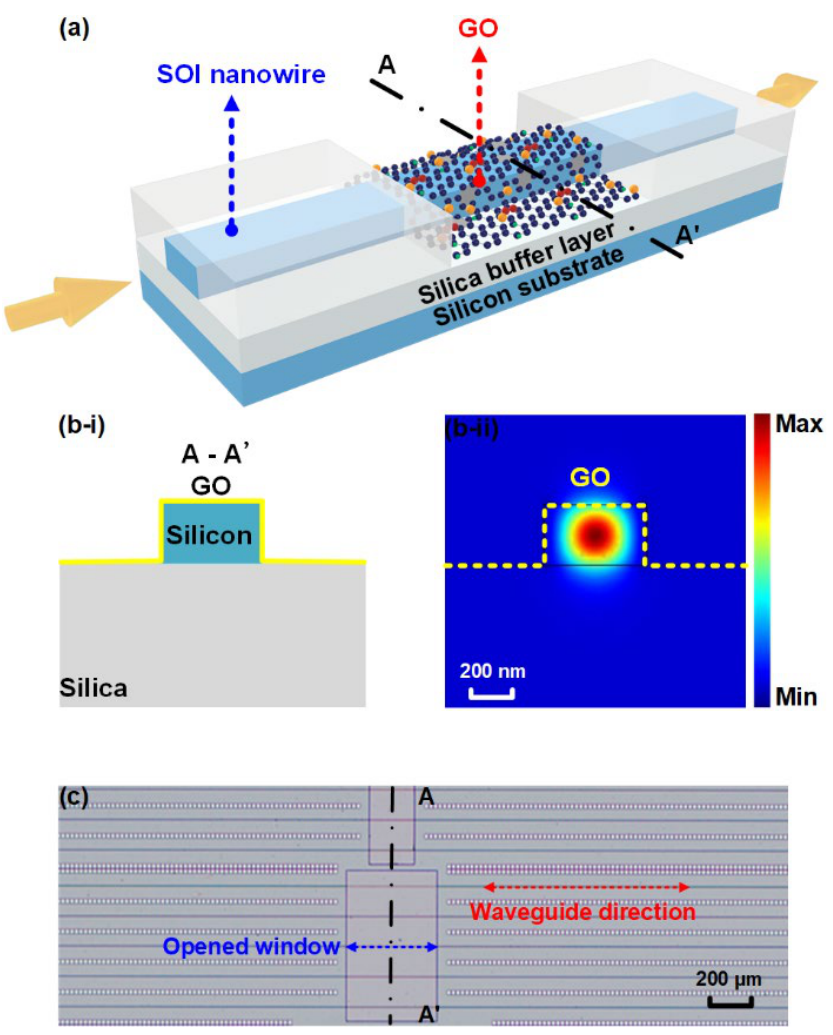
Figure 1. ( a ) Schematic illustration of a GO-coated SOI nanowire with a monolayer GO film. ( bi ) Schematic illustration of the cross section and ( bii ) the corresponding TE mode profile of the GO- coated SOI nanowire in ( a ). ( c ) Microscope image of an SOI chip uniformly coated with a monolayer GO